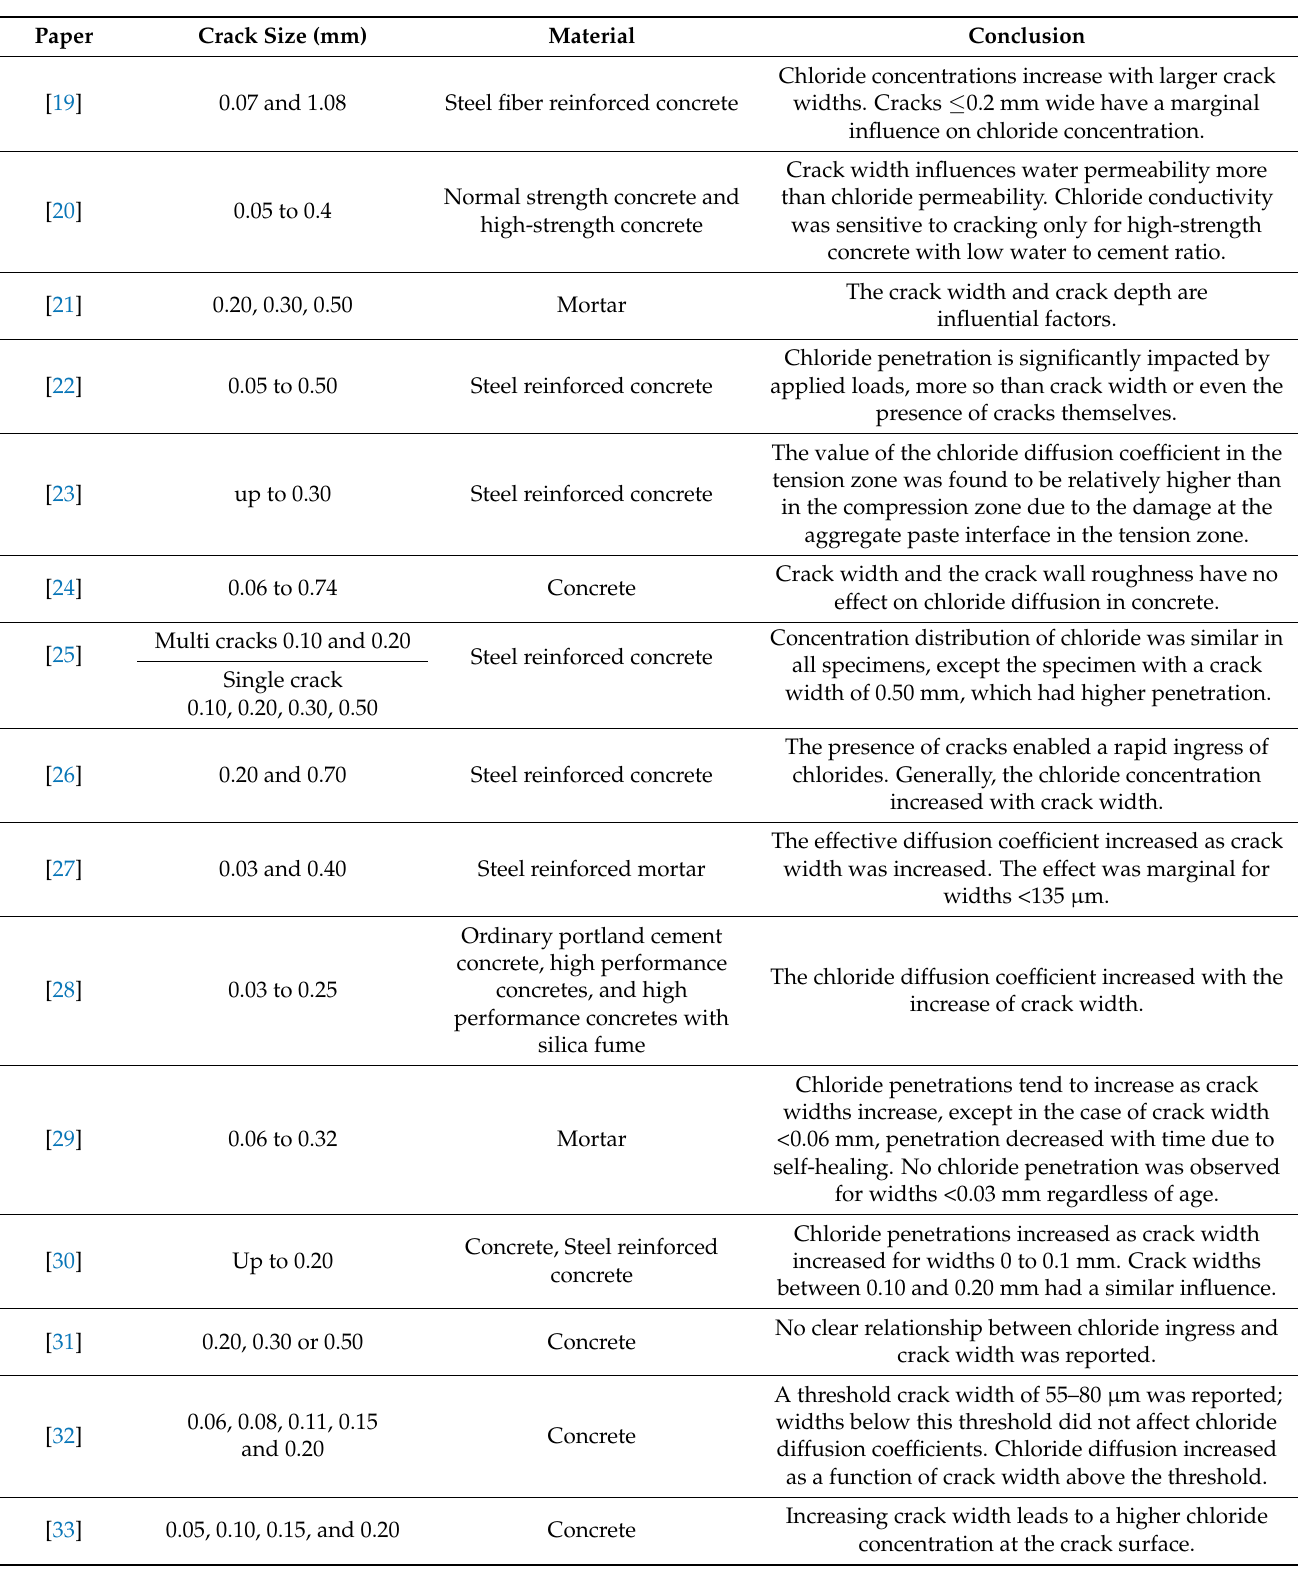
Table 2. Summary of some studies on chloride penetration in cracked